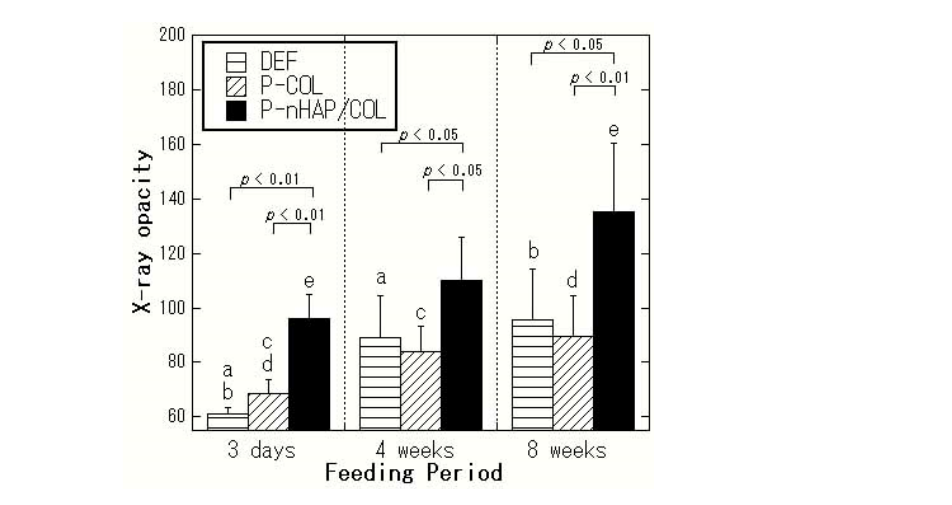
Figure 4. Micro-computed tomography (CT) images of cranial defects with and without implant materials (( a ): defect only (DEF), ( b ): P-COL, and ( c ): P-nHAP/COL)) at 3 days, 4 weeks, and 8 weeks after surgery.